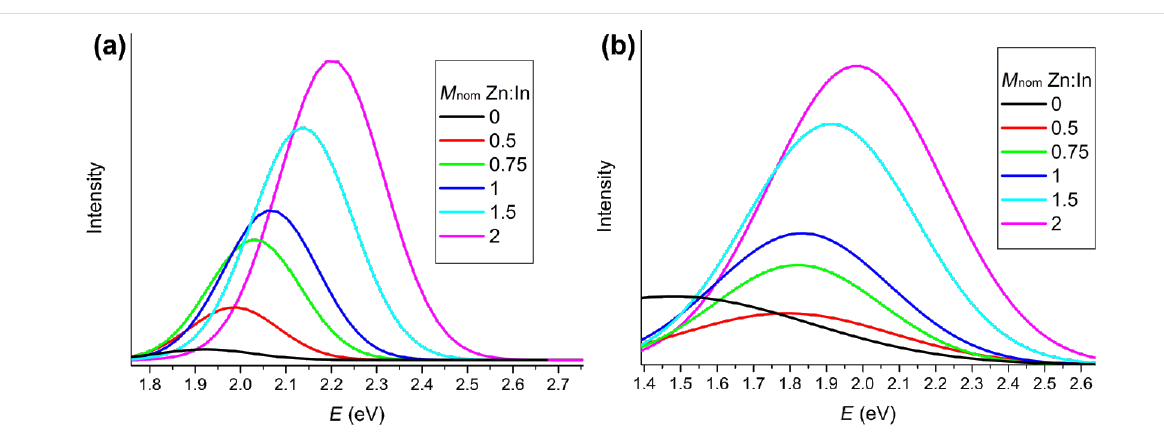
Figure 10: (a) Evolution of the excitonic peak with increasing M nom ; (b) evolution of the defect peak with increasing M nom .